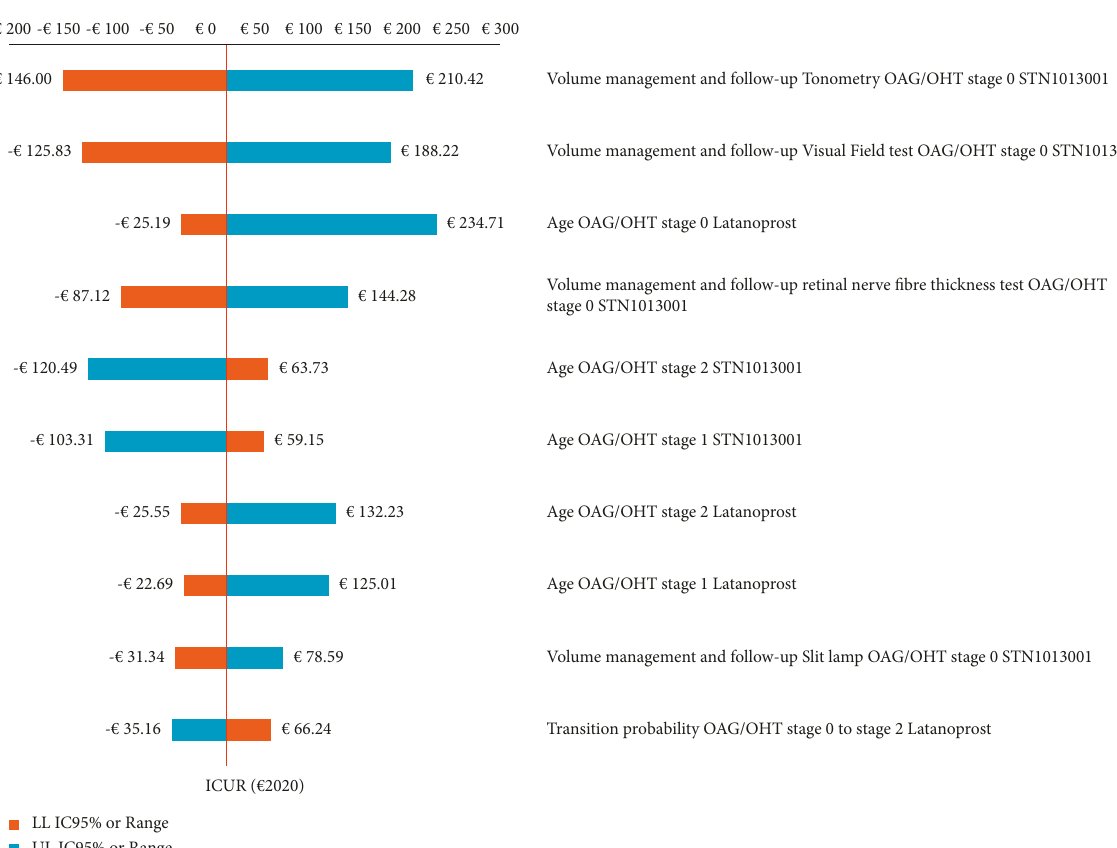
Figure 3: One-way sensitivity analysis–results concerning the first 10 parameters of the Markov model that causes the widest variations in base case ICUR STN1013001 ( 21.26; NE sector of the cost-effectiveness plane) (